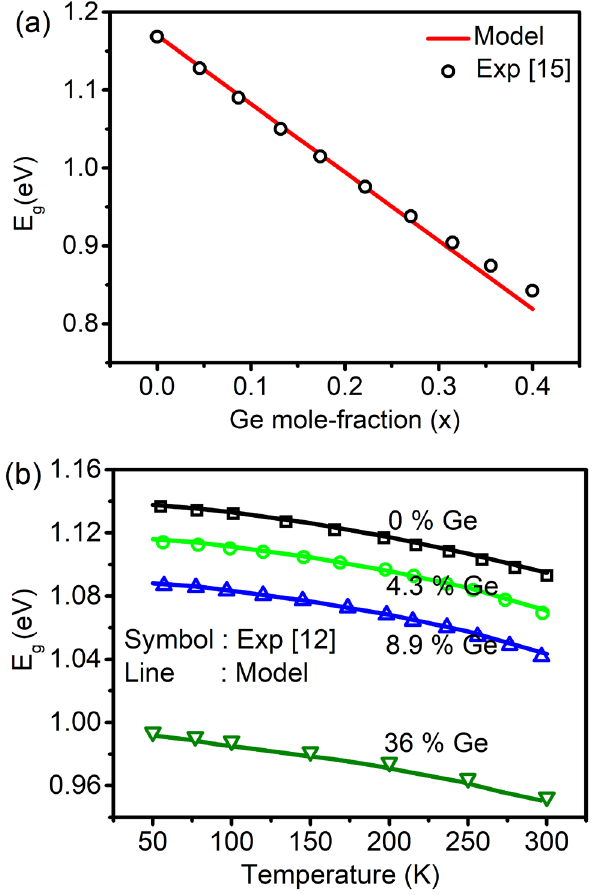
Figure 1. ( a ) The analytical model (1) calibrated at different Ge mole fractions with experimental data [15]; ( b ) for the wide range of temperature, the computed expression observed closely matched with measurement data [12].